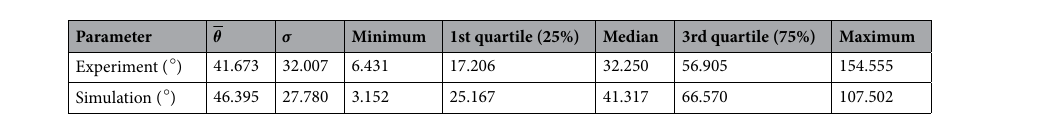
Table 1. Absolute turning angle of comparison cases in Fig.